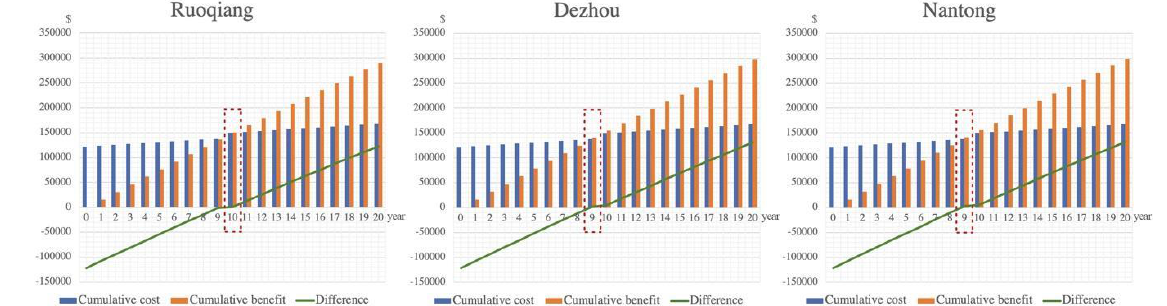
Figure 8 The distribution of the life-cycle PV generation power and revenues.